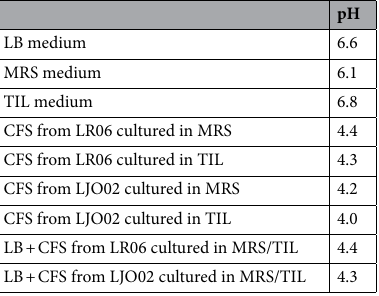
Table 1. pH measurement of culture media and CFSs used in the study. pH values of LB, alone and plus an equal volume of each one of the CFSs produced by the LAB in MRS and TIL media. The pH of pristine MRS and TIL broths is also